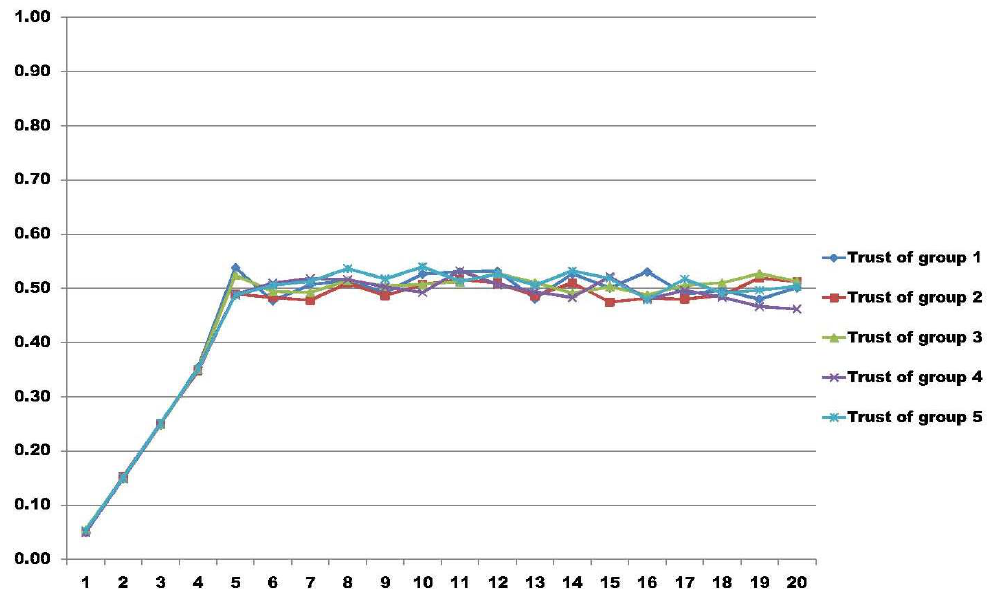
Figure 3. Worst scenario where all nodes in all groups behave